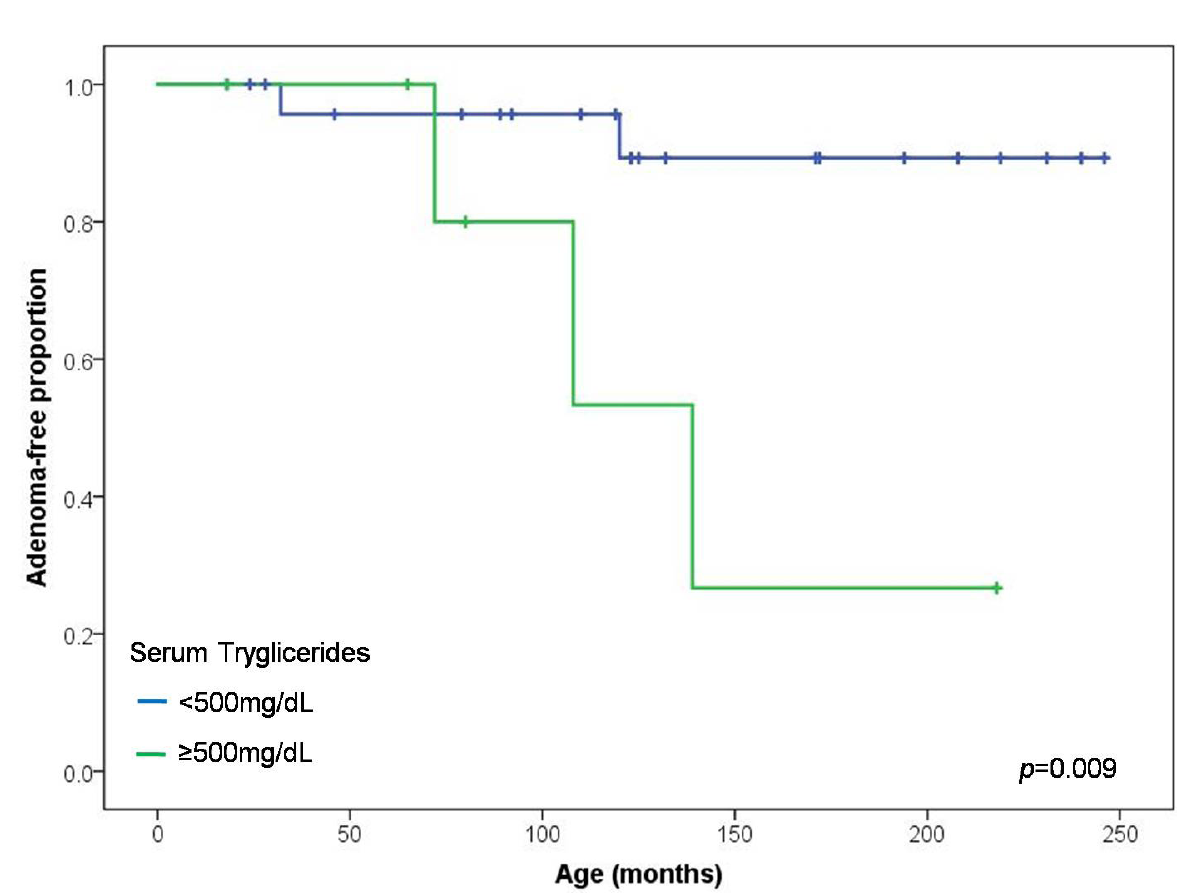
Figure 5. Kaplan-Meier survival curve of adenoma-free progression in GSD I based on three-year mean triglyceride concentration. p value between both groups is